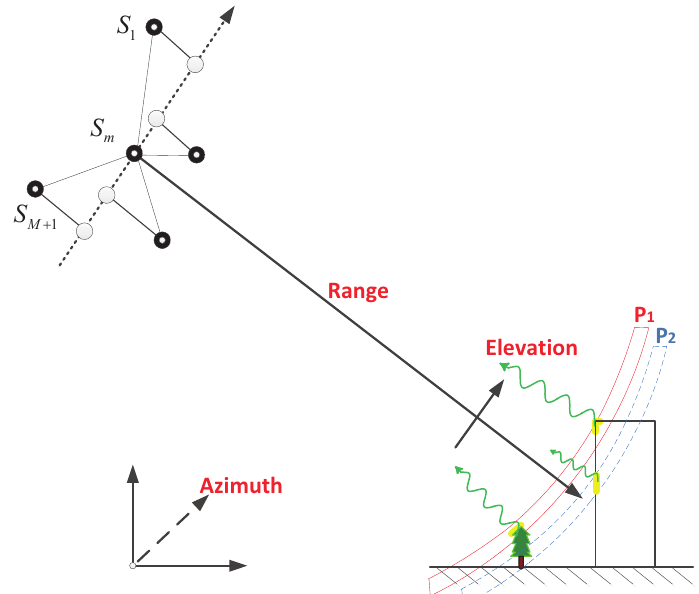
Figure 2. Geometric diagram of two resolution cells: P 1 represents a layover pixel with two strong point-like scatterers’ superposition and P 2 represents a PS pixel within only one scatterer from building